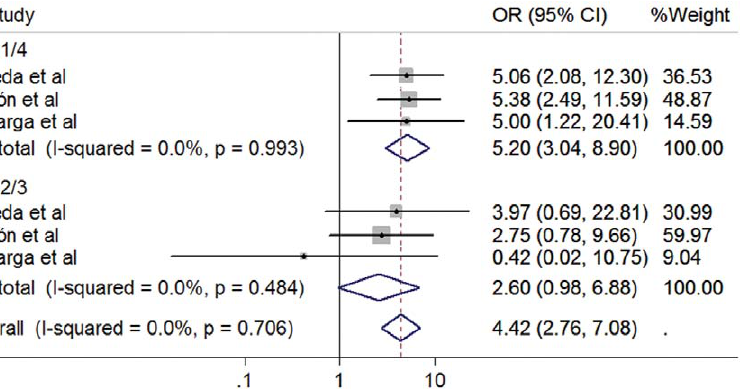
Figure 5. Forrest plot for association between rs12979860 polymorphisms and response to PegIFN/RBV in HIV co-infected patients.